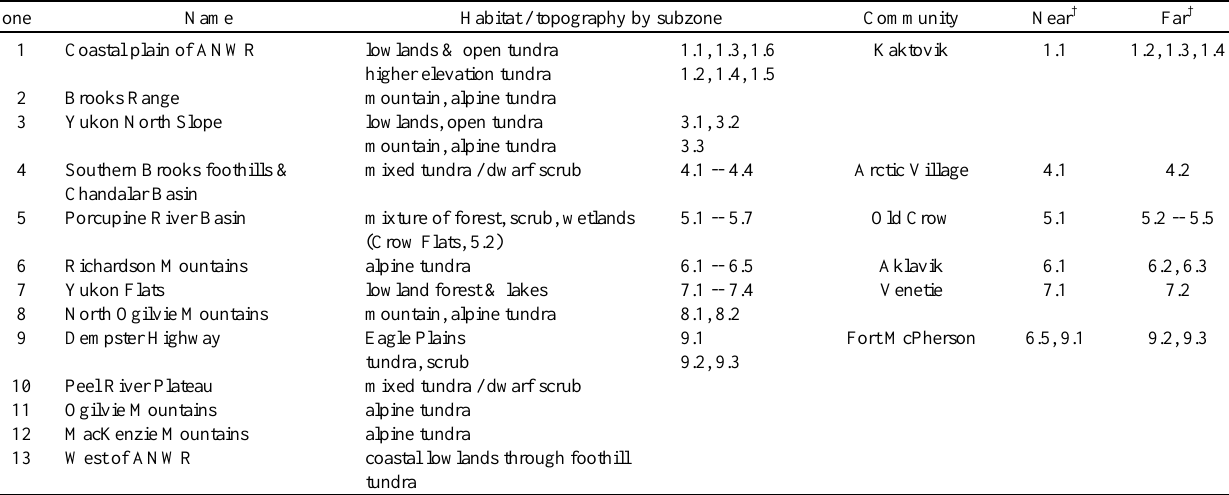
Table 2 . Caribou movement zones and habitat types within each